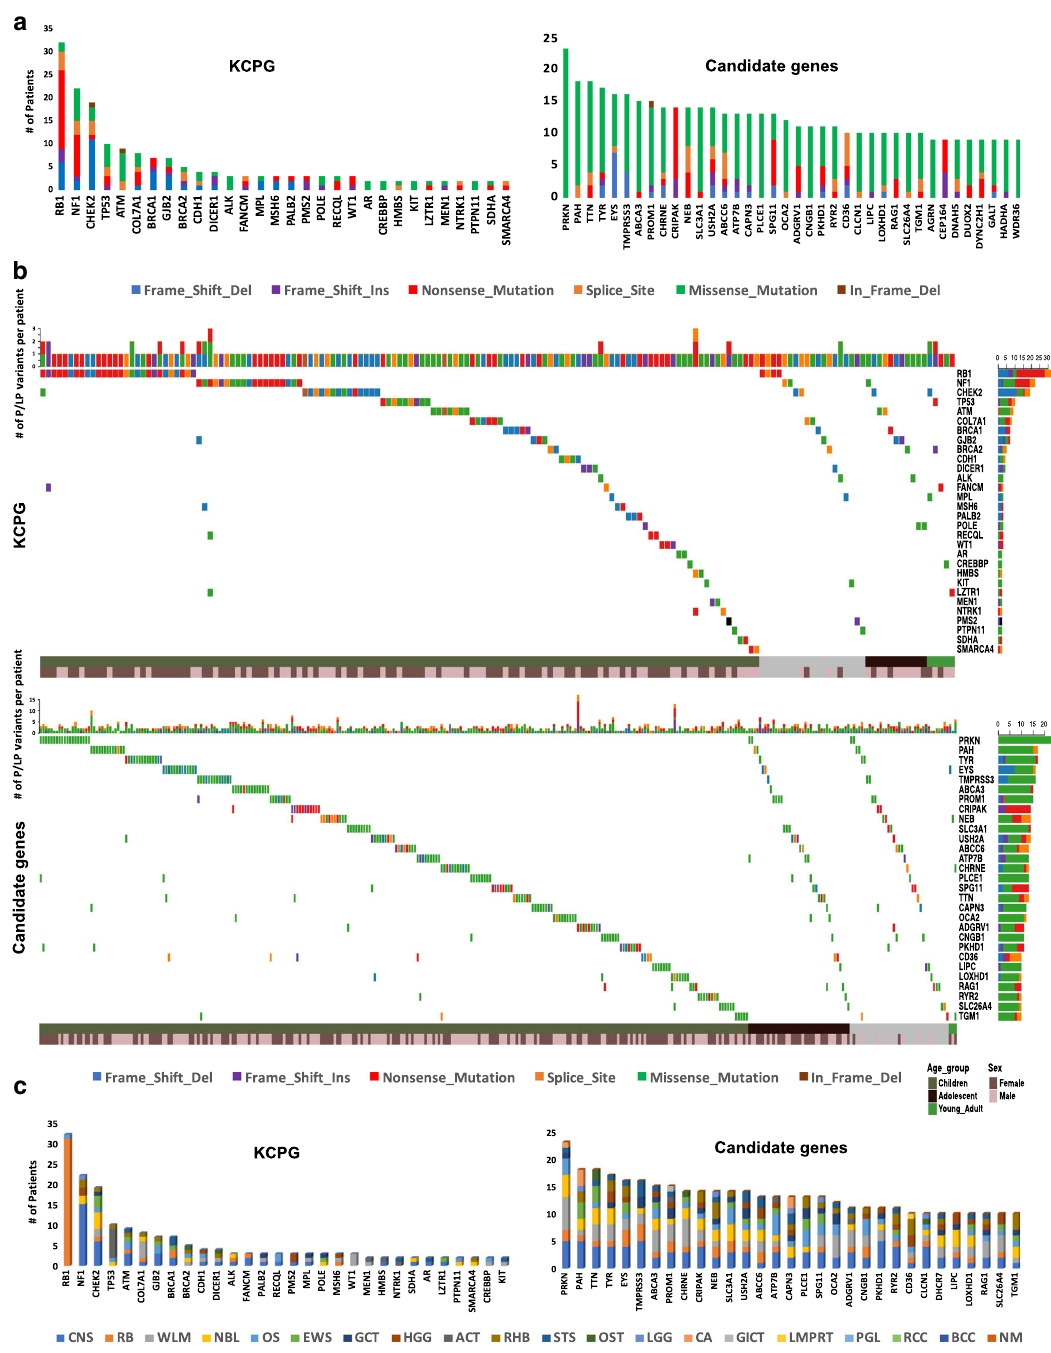
Fig. 2 Distribution of germline pathogenic/likely pathogenic (P/LP) mutations in children, adolescents, and young adults (C-AYA) with solid tumors. a Top mutated genes with germline P/LP variants in KCPG (left panel) and candidate genes (right panel) and their type of alterations. b Oncoplots of top mutated genes with P/LP variants in known cancer-predisposing genes (KCPG) (top panel) and candidate genes (lower panel) based on the age group. Each column represents one patient and its affected genes. c Most frequently mutated genes with P/LP variants in KCPG (left panel) and candidate genes (right panel) based on their affected tumor types. ACT adrenocortical carcinoma, BCC basal cell carcinoma, CA carcinoma, CNS central nervous system, EWS Ewing sarcoma, GCT germ cell tumor, GICT giant cell tumor, HGG high-grade glioma, LGG low-grade glioma, LMPRT low malignancy potential renal tumor, NBL, neuroblastoma, NM non-malignant tumor, OS osteosarcoma, OST other solid tumors, PGL paraganglioma, RB retinoblastoma, RCC renal cell carcinoma, RHB rhabdomyosarcoma, STS soft tissue sarcoma, WLM Wilms tumor, Del deletion, Ins Germline genomic signatures across solid tumor types . To fi nd glioma tumors had the highest number of germline P/LP variants a germline genomic signature for each tumor type, we classi fi ed (combined KCPG and candidate genes) per sample, 3.6 and 2.8, our germline data by individual tumor type, for 12 speci fi c types respectively, compared to the overall 1.9 P/LP variants per sam- of solid tumors (samples ranging from 22 to 323 cases per tumor ple. Half of the individuals with ACT and 45% of retinoblastoma type). Individuals with adrenocortical carcinoma and high-grade cases carried at least one KCPG P/LP variant per patient. While